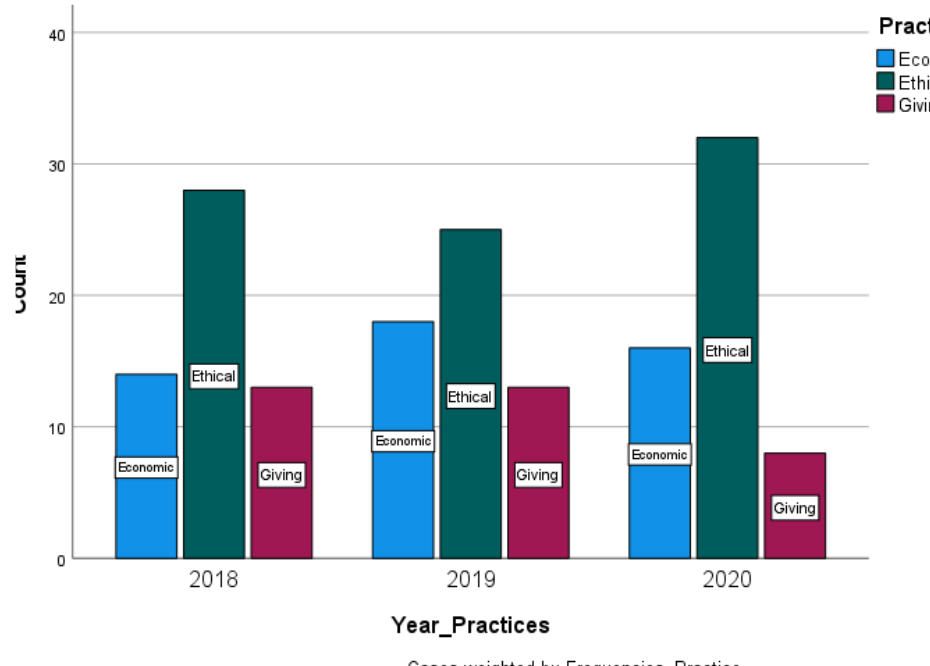
Figure 3: Practices Emphasized by